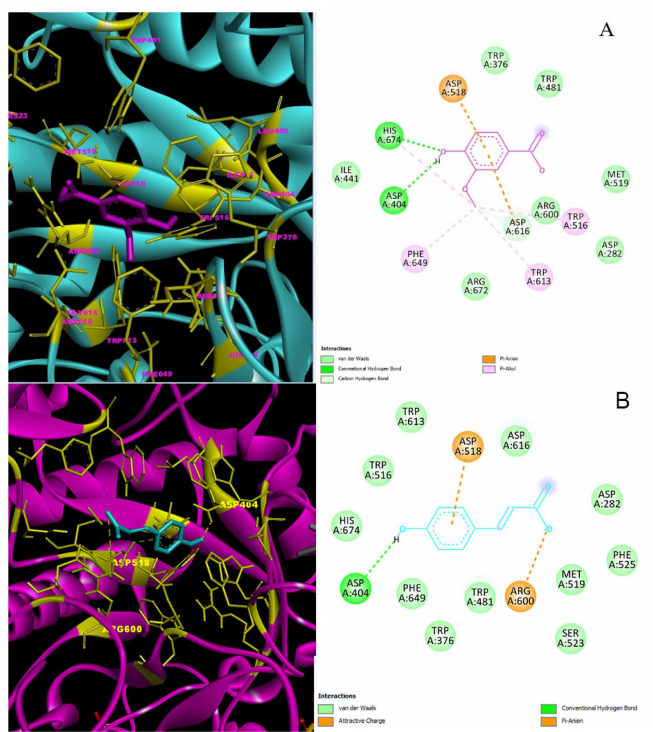
Figure 5. The 2D and 3D interaction profiles and best interaction poses of major phenolic com- pounds placed into the α -glycosidase (5NN8) by docking study: ( A ) Vanillic acid– α -glycosidase; ( B ) p -Coumaric acid– α -glycosidase.